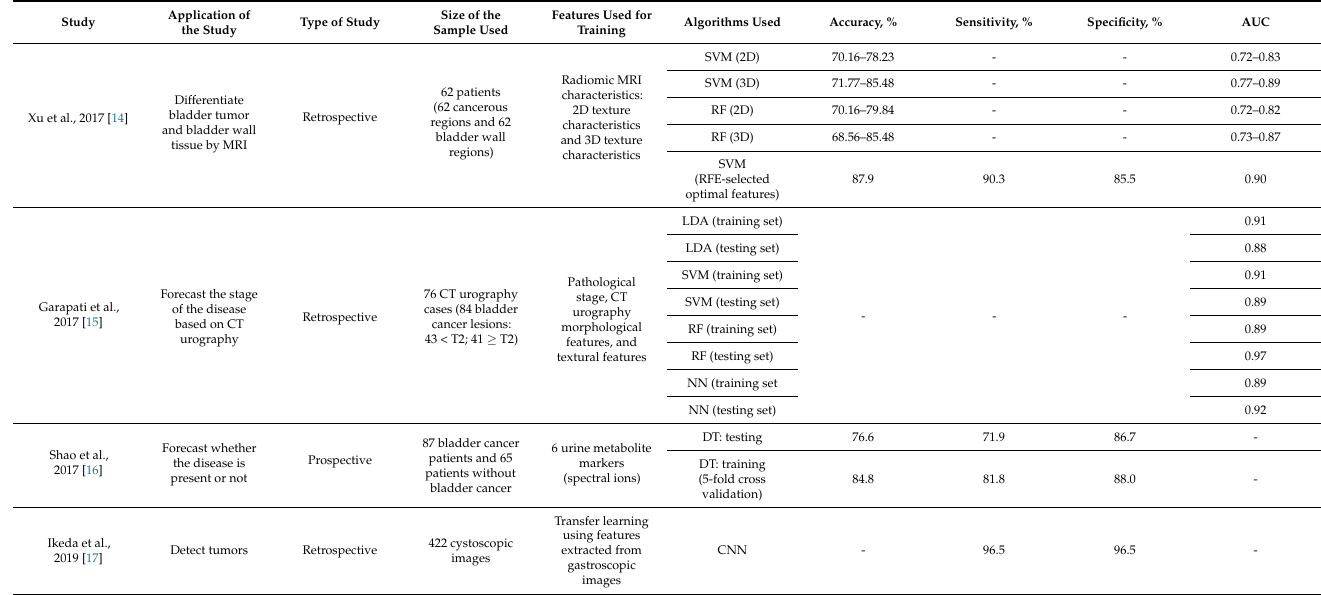
Table 2. Studies using AI to diagnose urothelial